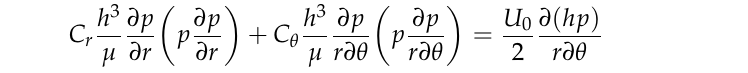
Table 2. Fluid state coefficients according to laminar, turbulent and slip conditions. Fluid Condition C r C θ Laminar 1/12 1/12 Turbulent 1/ G r 1/ G θ Slip q p